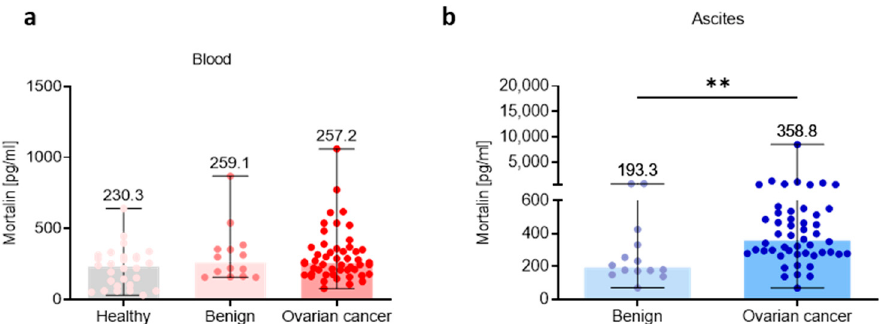
Figure 1. Mortalin profile in the peripheral blood and local ascites tumor environments. Soluble mortalin levels were measured ( a ) in the blood plasma from cohorts of healthy, benign ovarian tumors patients, and ovarian cancer patients, and ( b ) in the ascites fluid from cohorts of benign ovarian tumors patients, and ovarian cancer patients. Bars represent medians and ranges. Significant differences between study groups are marked using asterisks: ** p < 0.01.